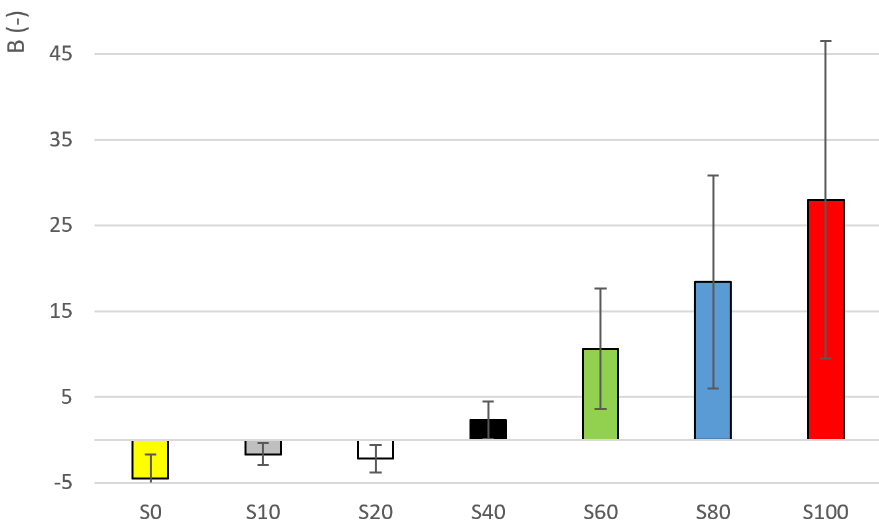
Figure 7. Parameter (cid:1828) values for samples S0–S100.